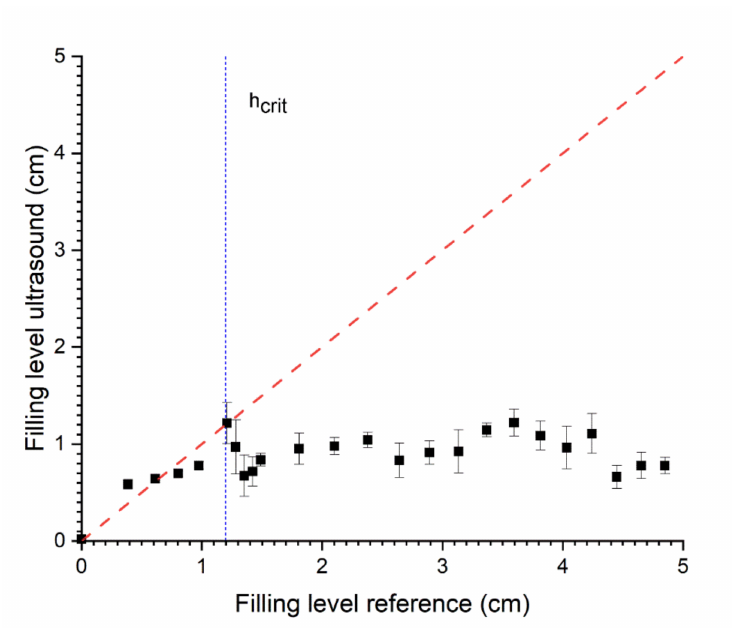
Figure 7. Relationship between the predicted level and SAW in pitch-catch mode with two transduc- ers side-mounted and reference (volumetric determination). R 2 = − 1.02 and RMSE = 2.37 (N =